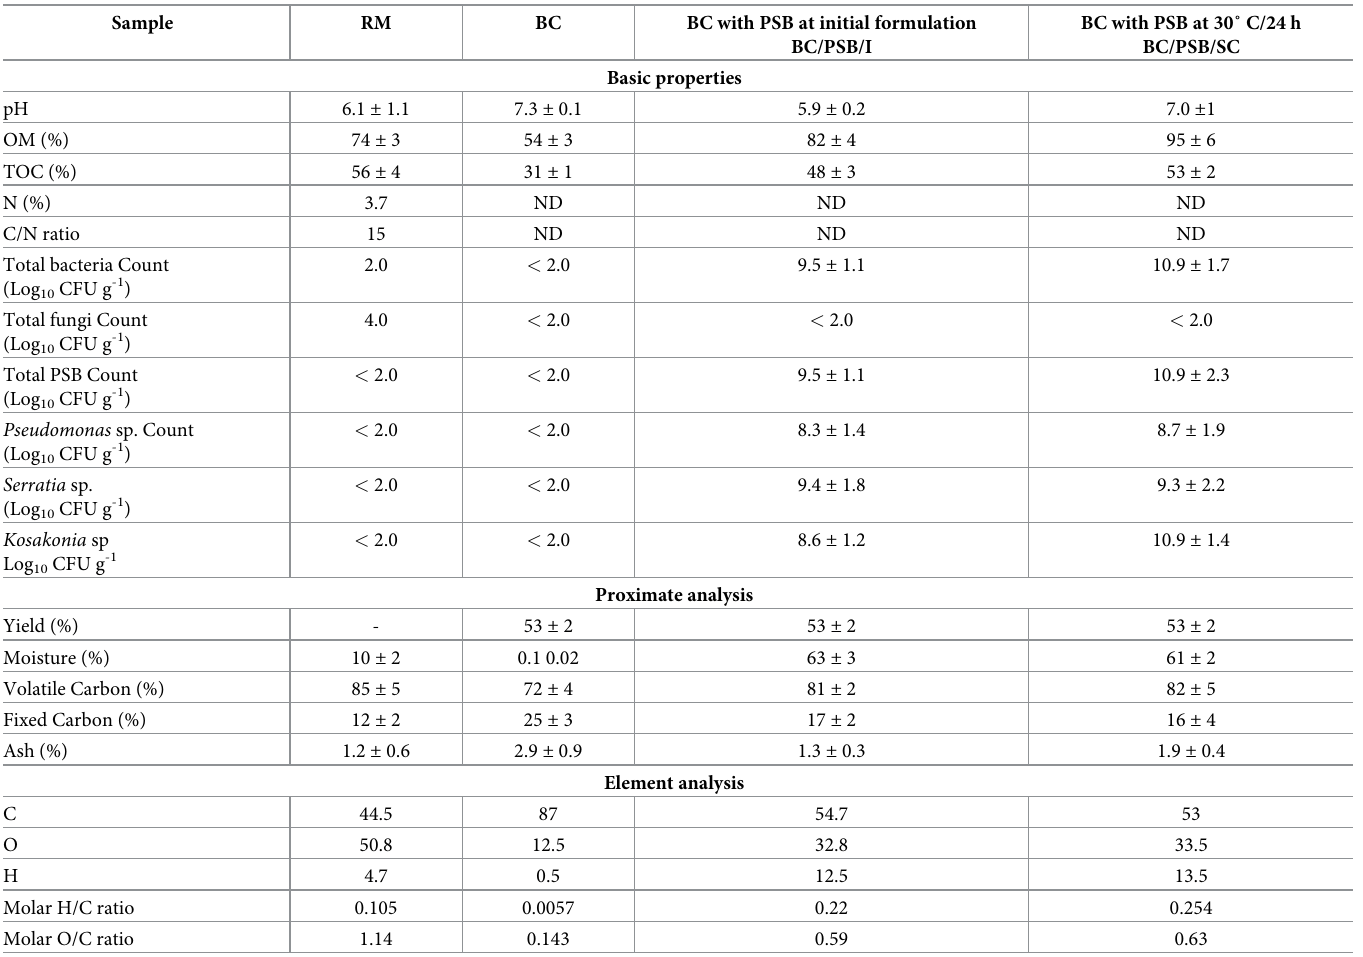
Table 2. Raw matter proximate and element analysis for biochar produced and PSB